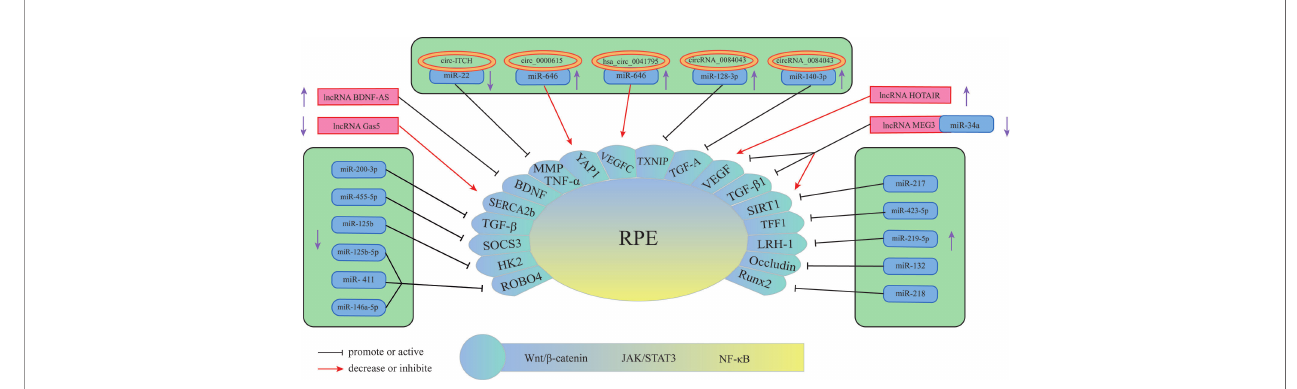
FIGURE 3 | Schematic overview of miRNAs, lncRNAs, and circRNAs affecting RPE and contributing to the pathogenesis of DR.